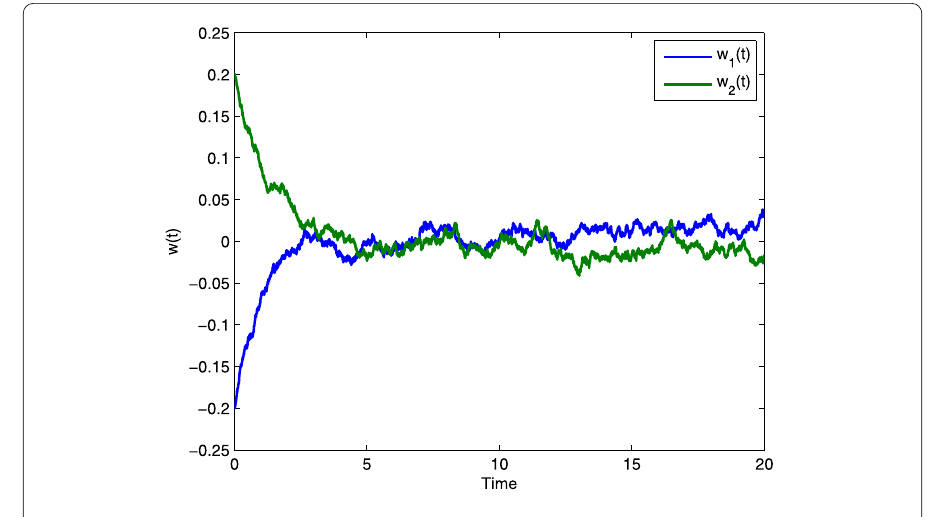
Figure 2 The trajectories of w 1 ( t ) and w 2 ( t ) in Example 4.3